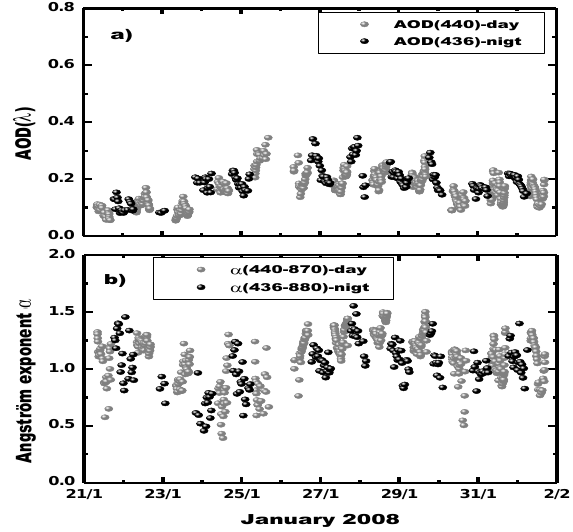
Fig. 11. Daytime and nighttime evolutions of columnar aerosol properties for the period from 21 January to 2 February 2008. (a) Aerosol optical depth (AOD). (b) Angström exponent α.